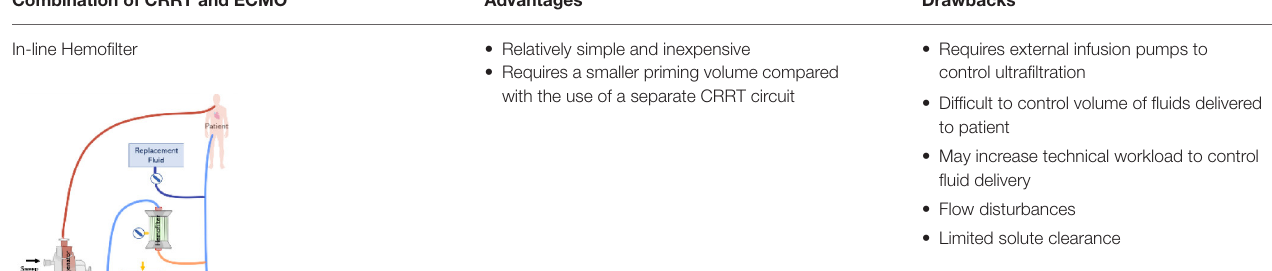
TABLE 1 | Review of main available methods of combining continuous renal replacement therapy (CRRT) and extracorporeal membrane oxygenation (ECMO) (11, 12, 18). Combination of CRRT and